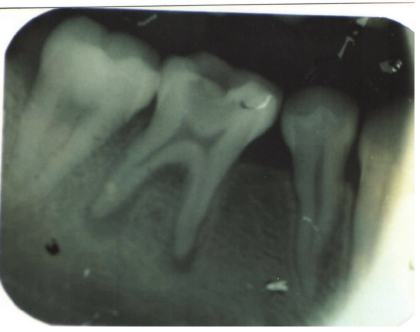
Figure 1: Before operation (36).